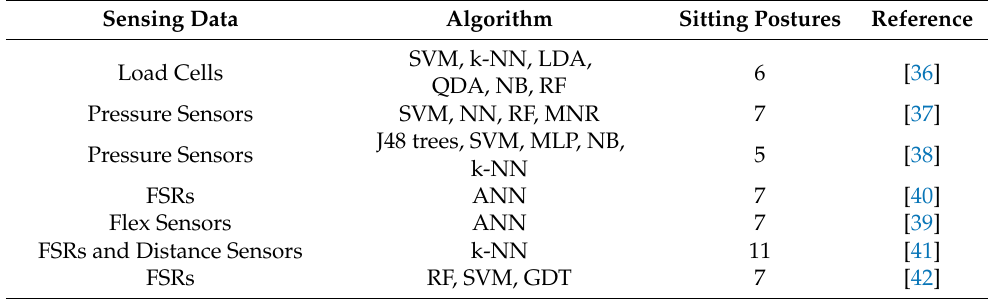
Table 1. Summary of the key related works in sitting posture recognition from sensing data using machine